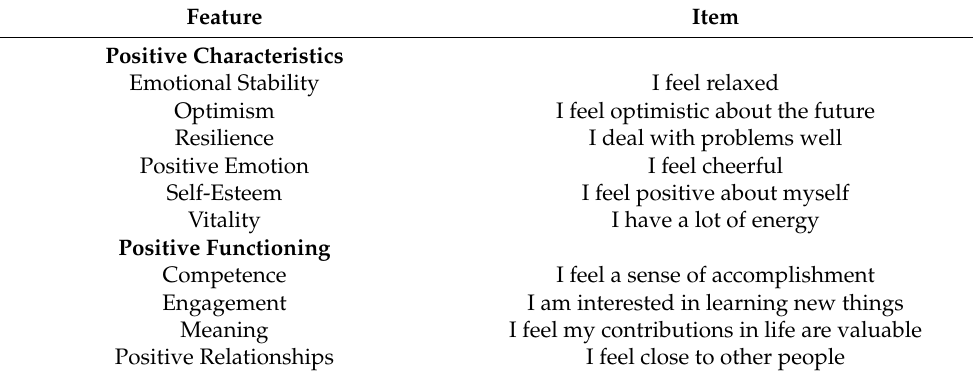
Table 1. Ten features of positive wellbeing